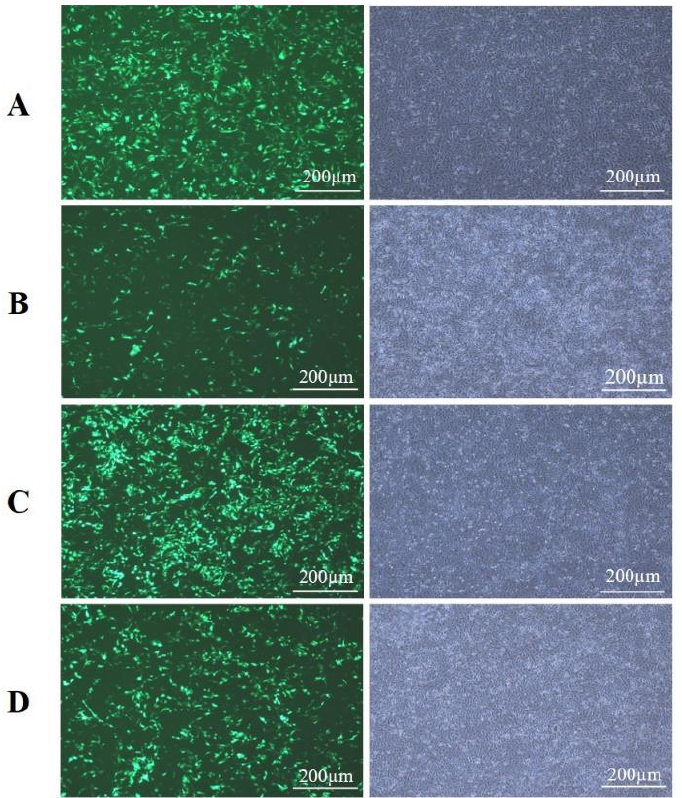
Figure 8. Cell morphology and GFP expression in BMECs under a fluorescence microscope after 24 h of transfection with; ( A ) pBI-CMV3- KLF6 , ( B ) pBI-GFP-Neo-CMV3, ( C ) pb7sk- KLF6 -siRNA1, ( D ) pb7sk-GFP-Neo.